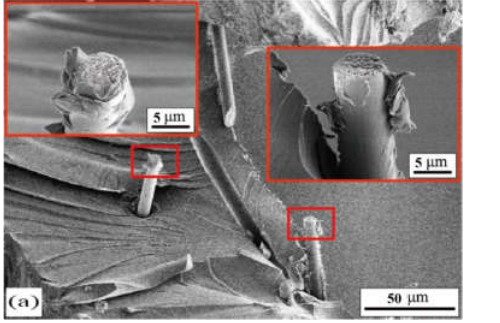
Figure 13. SEM images of fracture surfaces of ( a ) carbon fiber breaks in the vertical direction ( b ) adhesive adhering to the side of the carbon fiber.